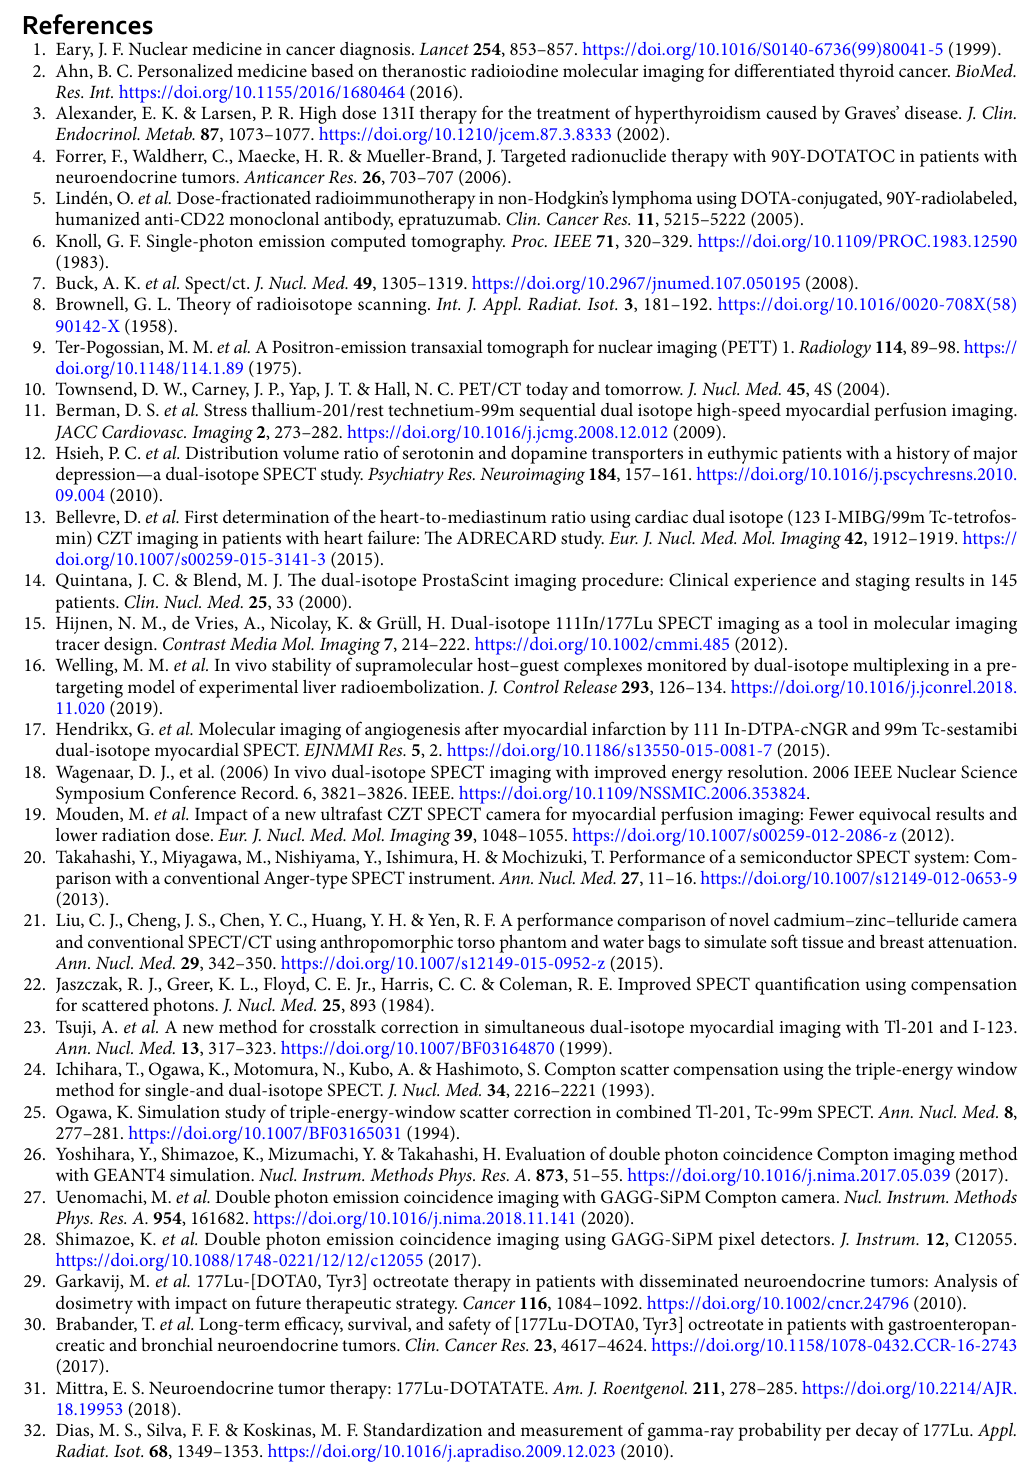
where V b is the background value calculated as the mean of six pixel